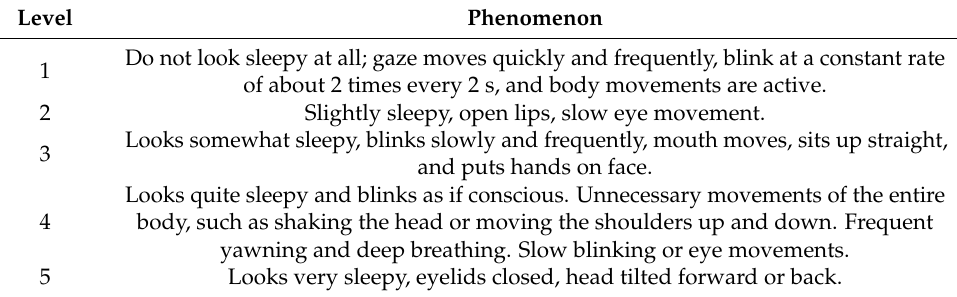
Table 4. Trained observer